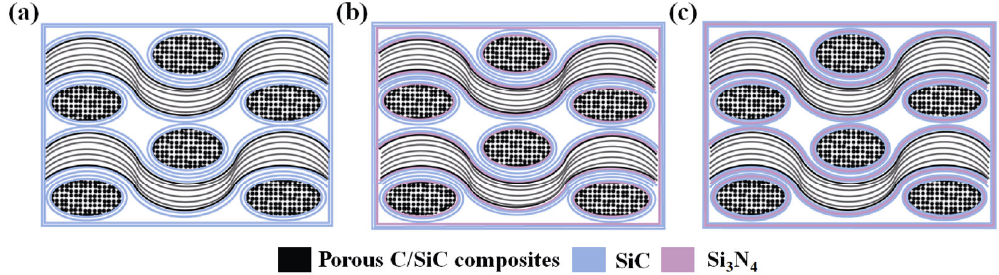
Fig. 1 Schematic deposition sequences of multilayer matrices for the as-prepared three composites processed by